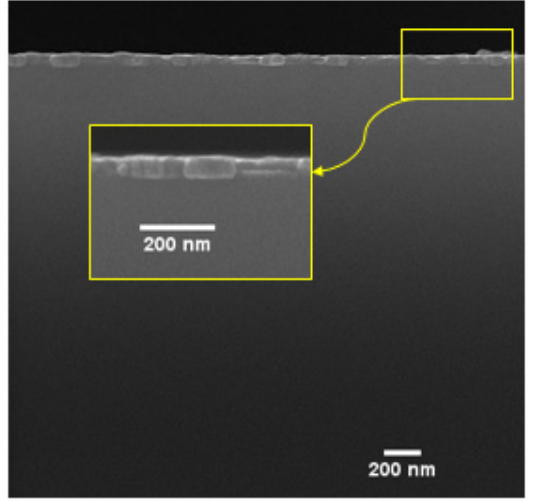
Figure 3. Cross-sectional FESEM image of sample